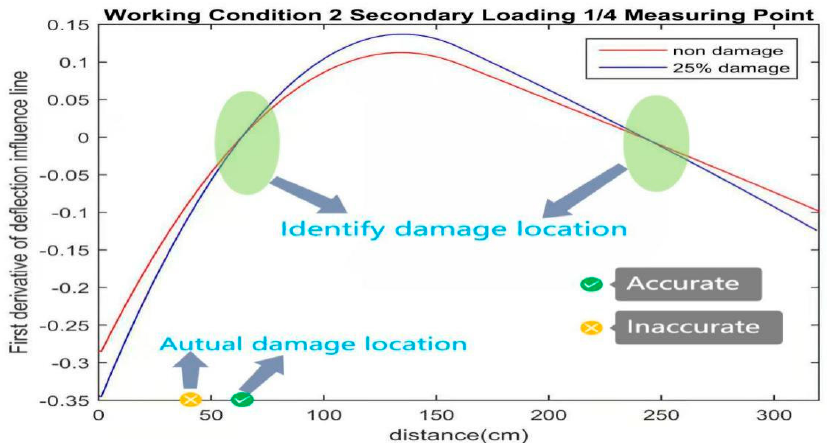
Figure 30. The first derivative of deflection influence line at 25/100 determining point of the first span following condition 5.